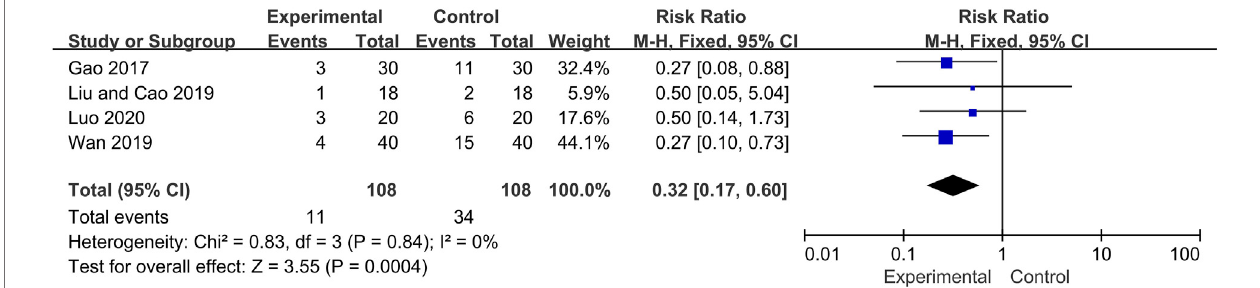
FIGURE 8 | Forest plot of adverse events.